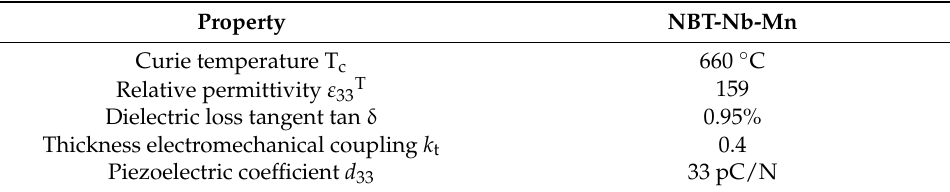
Table 1. Dielectric, electromechanical, and piezoelectric properties of piezoelectric materials. Property NBT-Nb-Mn Curie temperature T c 660 ◦ C Relative permittivity ε 33T 159 Dielectric loss tangent tan δ 0.95% Thickness electromechanical coupling k t 0.4 Piezoelectric coefficient d 33 33